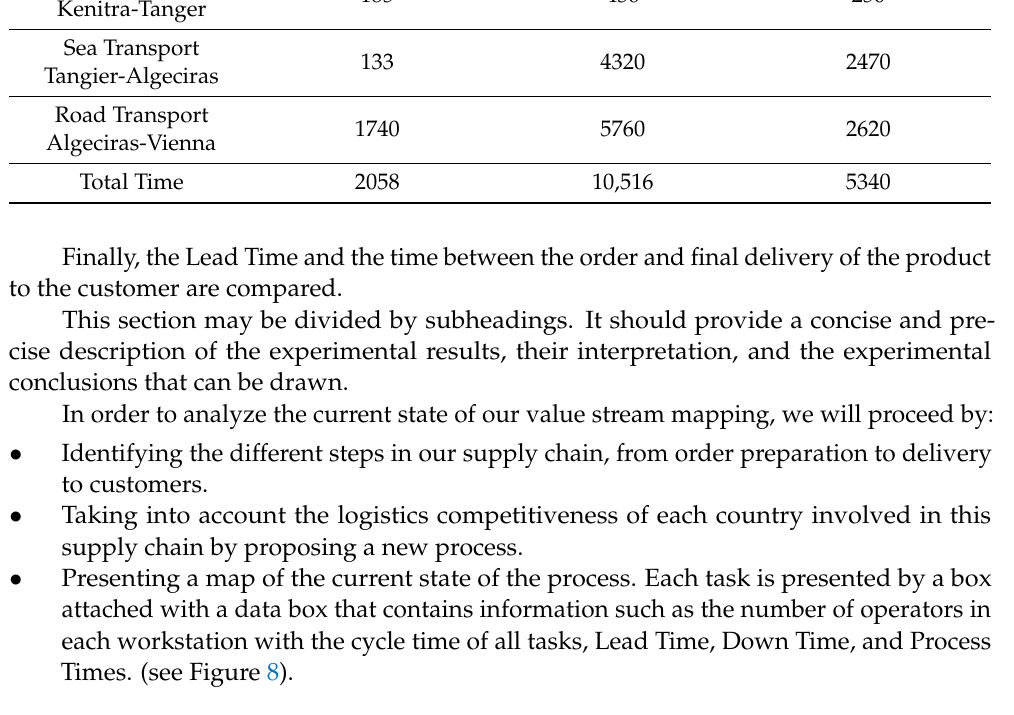
Table 8. Transportation Comparison Table between Current State and Future State 4.0.